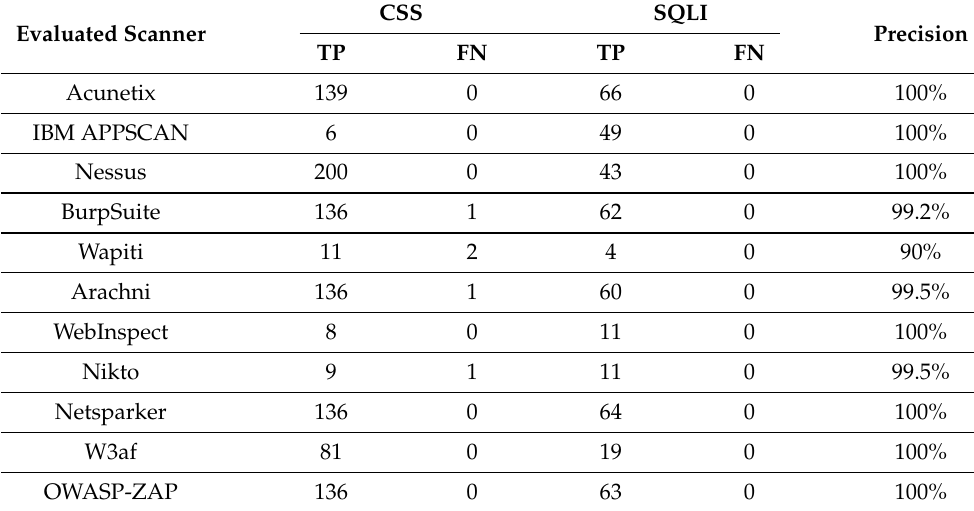
Table 6. Recall rate of evaluated